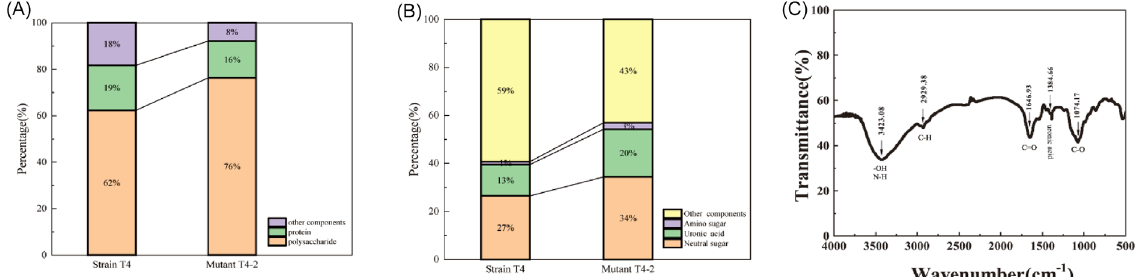
Fig. 3 Components in EPS from P. fluorescens T4 and mutant T4-2 ( A ), percentage of neutral sugar, uronic acid and amino sugar in EPS of P. fluorescens T4 and mutant T4-2 ( B ) and infrared spectra of EPS from P. fluorescens mutant T4-2 ( C